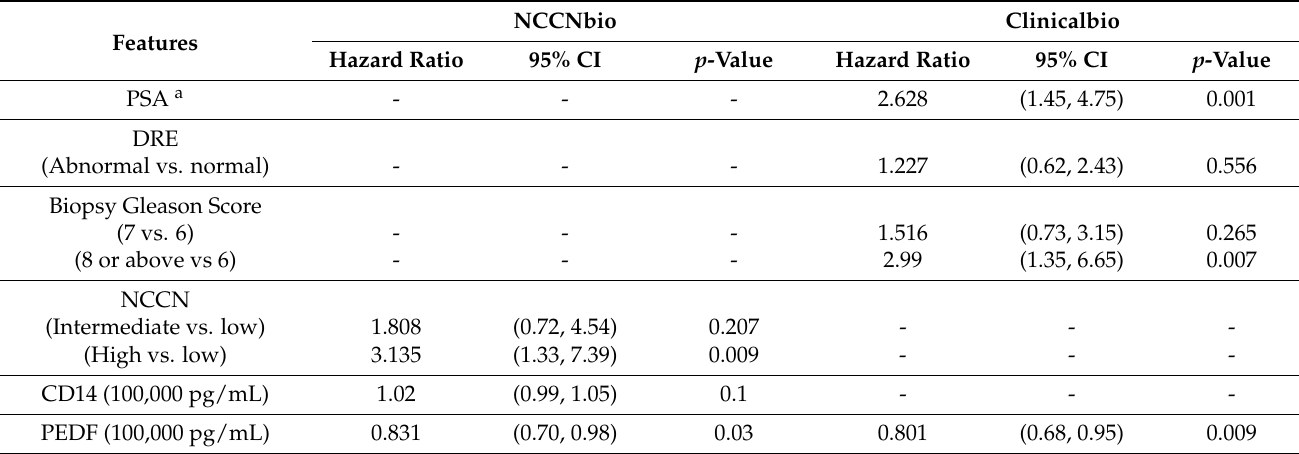
Table 2. Summary of the ‘NCCNbio’ and ‘Clinicalbio’ models developed for the Irish cohort using the hazard ratio, 95% confidence interval (CI) for the hazard ratio and p -value for the risk factors in the model. Features